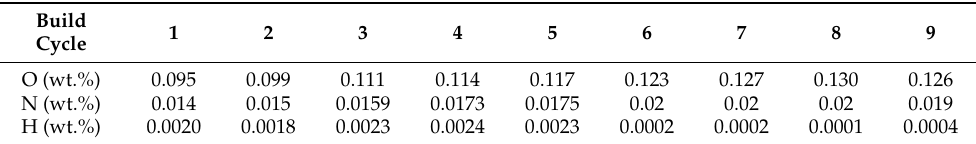
Figure 2. Scanning electron microscope image with magnification at ×1000. Table 1. Average chemical composition of the interstitial elements at each build cycle throughout a previously studied top-up reuse regime [5].